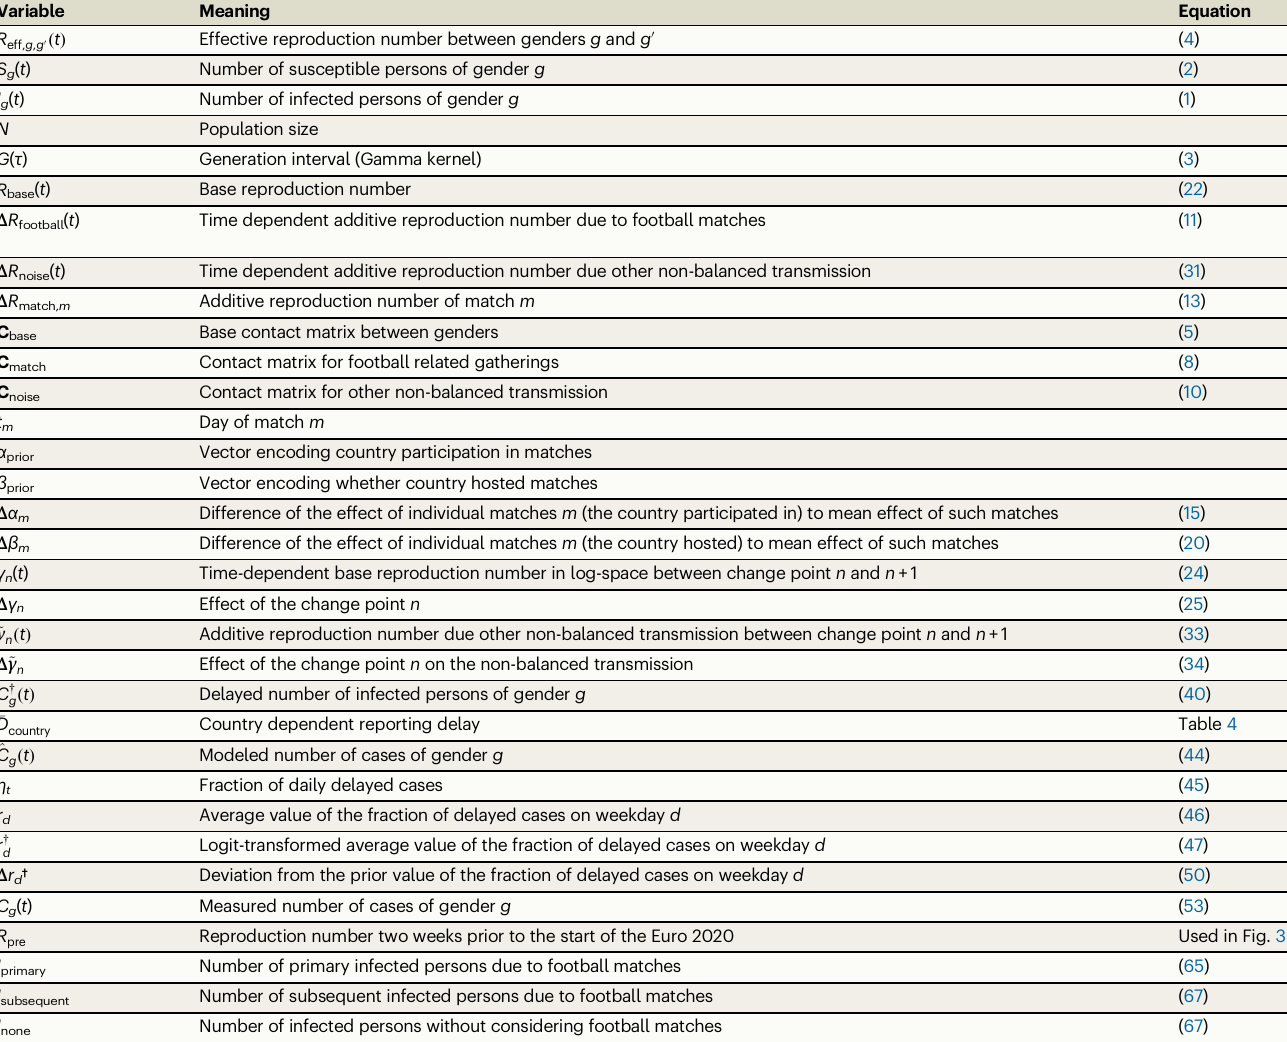
Table 1 | The intermediate variables of the model and their meaning